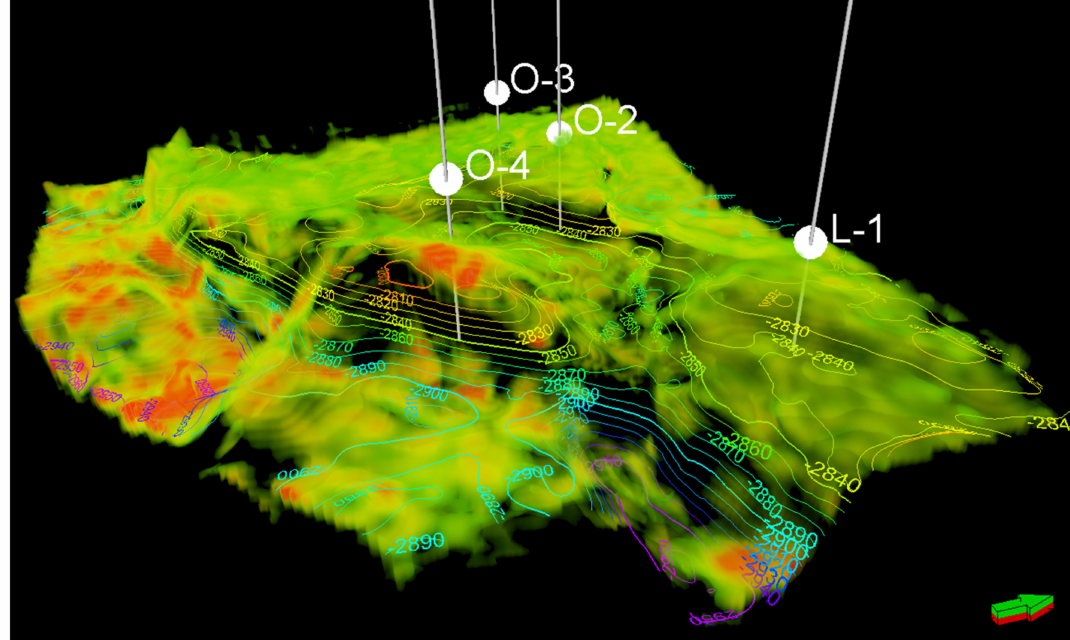
Figure 7. Spatial distribution of the most brittle spots within the analyzed